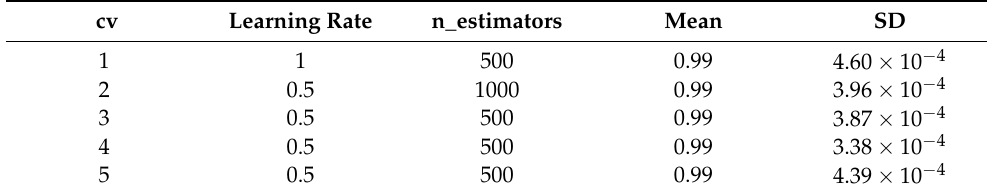
Table 8. Best AdaBoost model by iteration.